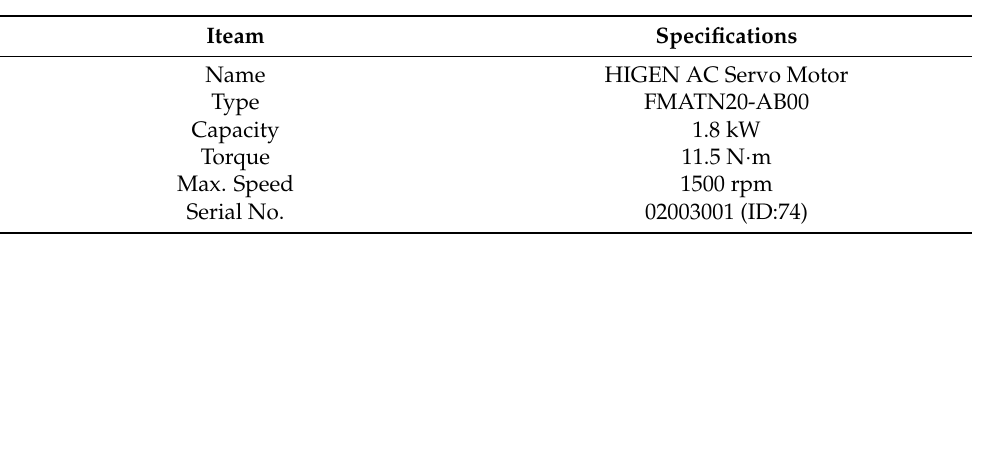
Figure 2. ( a ) Experimental setup; ( b ) scheme of top view of motor and position of bolt specimens and sensors; ( c ) torque wrench. Table 1. The specification of AC Servo Motor.